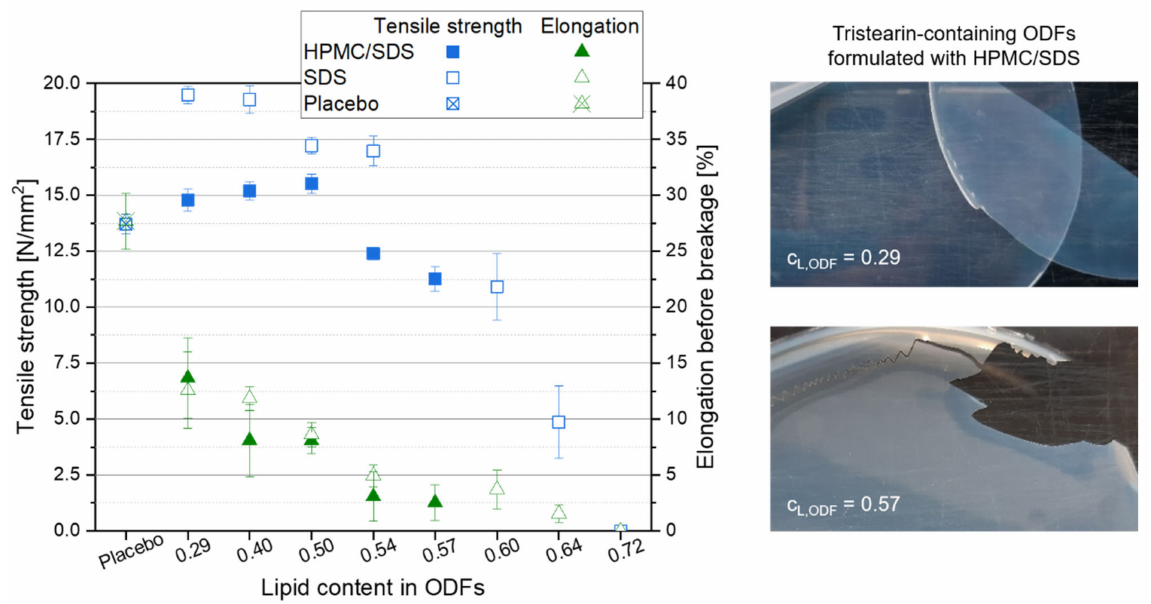
Figure 5. Mechanical properties of tristearin-containing ODFs loaded with various lipid contents as compared to a lipid-free placebo film (left, n = 6), and images of ODFs loaded with an HPMC/SDS-formulated tristearin suspension at lipid contents c L,ODF = 0.29 (right, top) and c L,ODF = 0.57 (right,